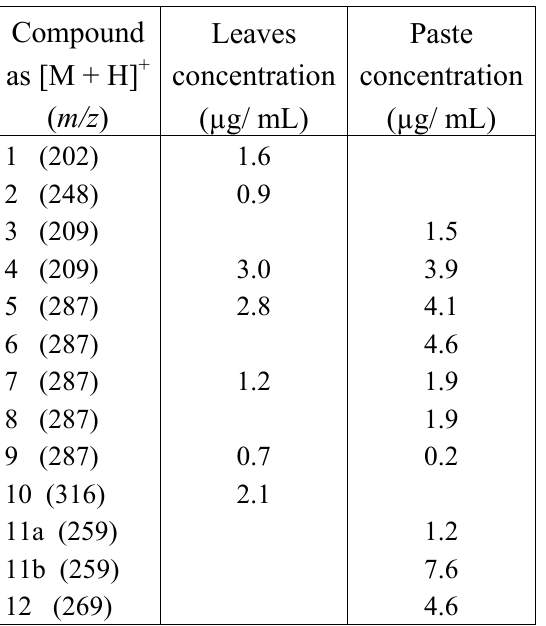
Table 1 . HPLC-ESI-MS analysis of leaf and paste extract (10 μ L injections). Areas of peaks and quantification are based on a calibration curve using a pure pilocarpine standard. Compounds are numbered as in Figure